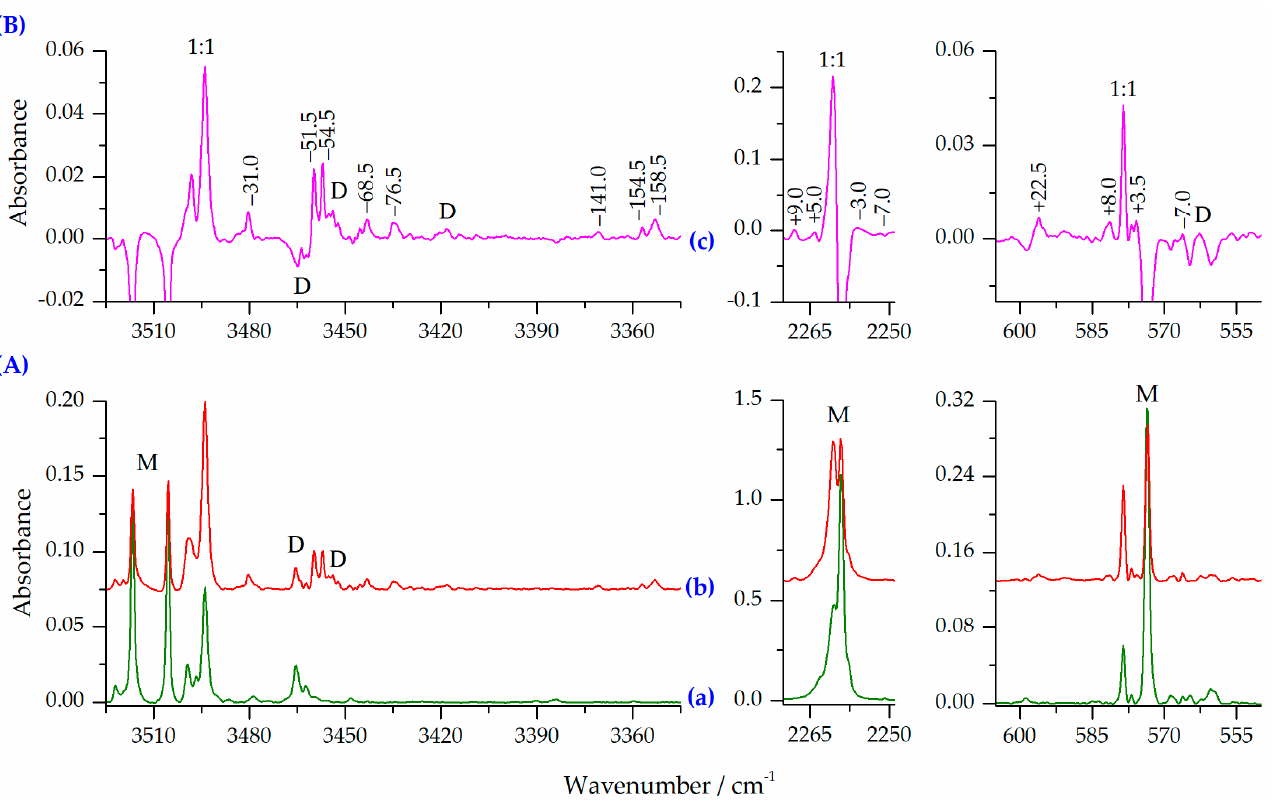
Figure 5. ( A ) The ν NH, ν as NCO and δ NCO regions in the spectra of matrices: HNCO/N 2 /Ar = 1/4/5600 (a), and matrix (a) after 10 min at 33 K/10 K (b); ( B ) the difference spectrum (c) obtained by subtracting the spectrum (a) from the spectrum (b) (pink trace). Letters M and D denote the HNCO monomer and dimer bands, respectively. Table 6. Selected wavenumber shifts (cm − 1 ) calculated for the 1:2 complexes using the MP2, B2PLYPD3 and B3LYPD3 methods with the 6-311++G(3df,3pd) basis set compared to the